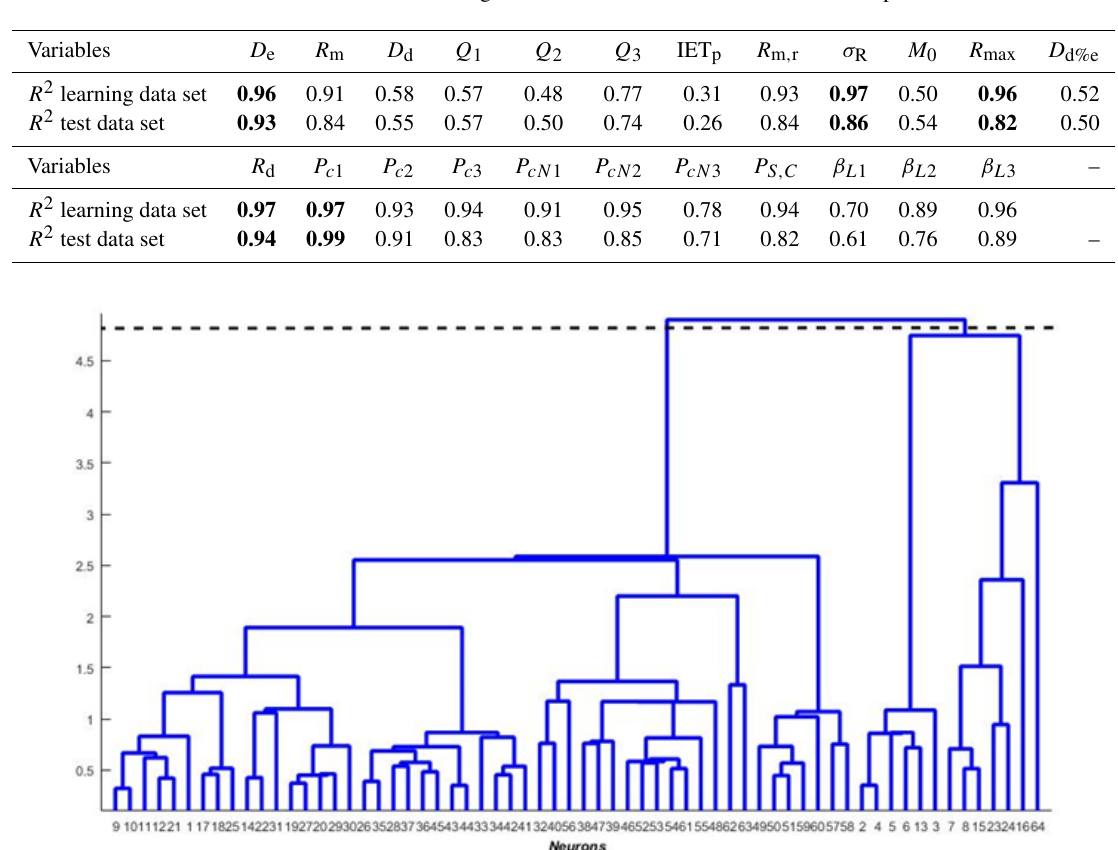
Figure 6. Dendrogram obtained from the hierarchical cluster analysis of the 64 neurons in the SOM. The horizontal dashed line represents the threshold between the two